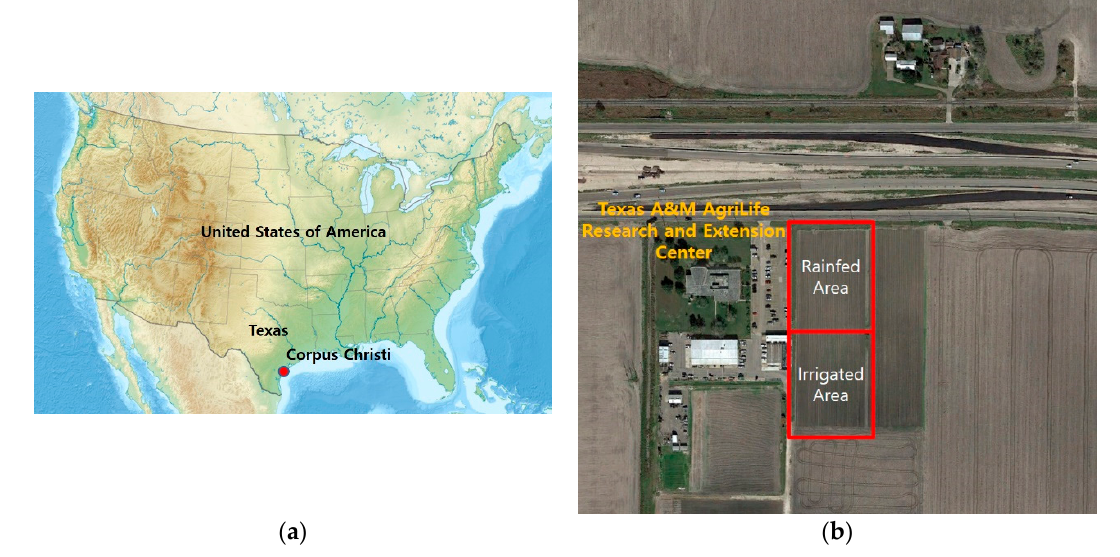
Figure 3. Location of the study area. ( a ) Corpus Christi, Texas; ( b ) Texas A&M AgriLife Research and Extension Center (27°46 ′ 58.33 ′′ N, 97°33 ′ 43.84 ′′ W).